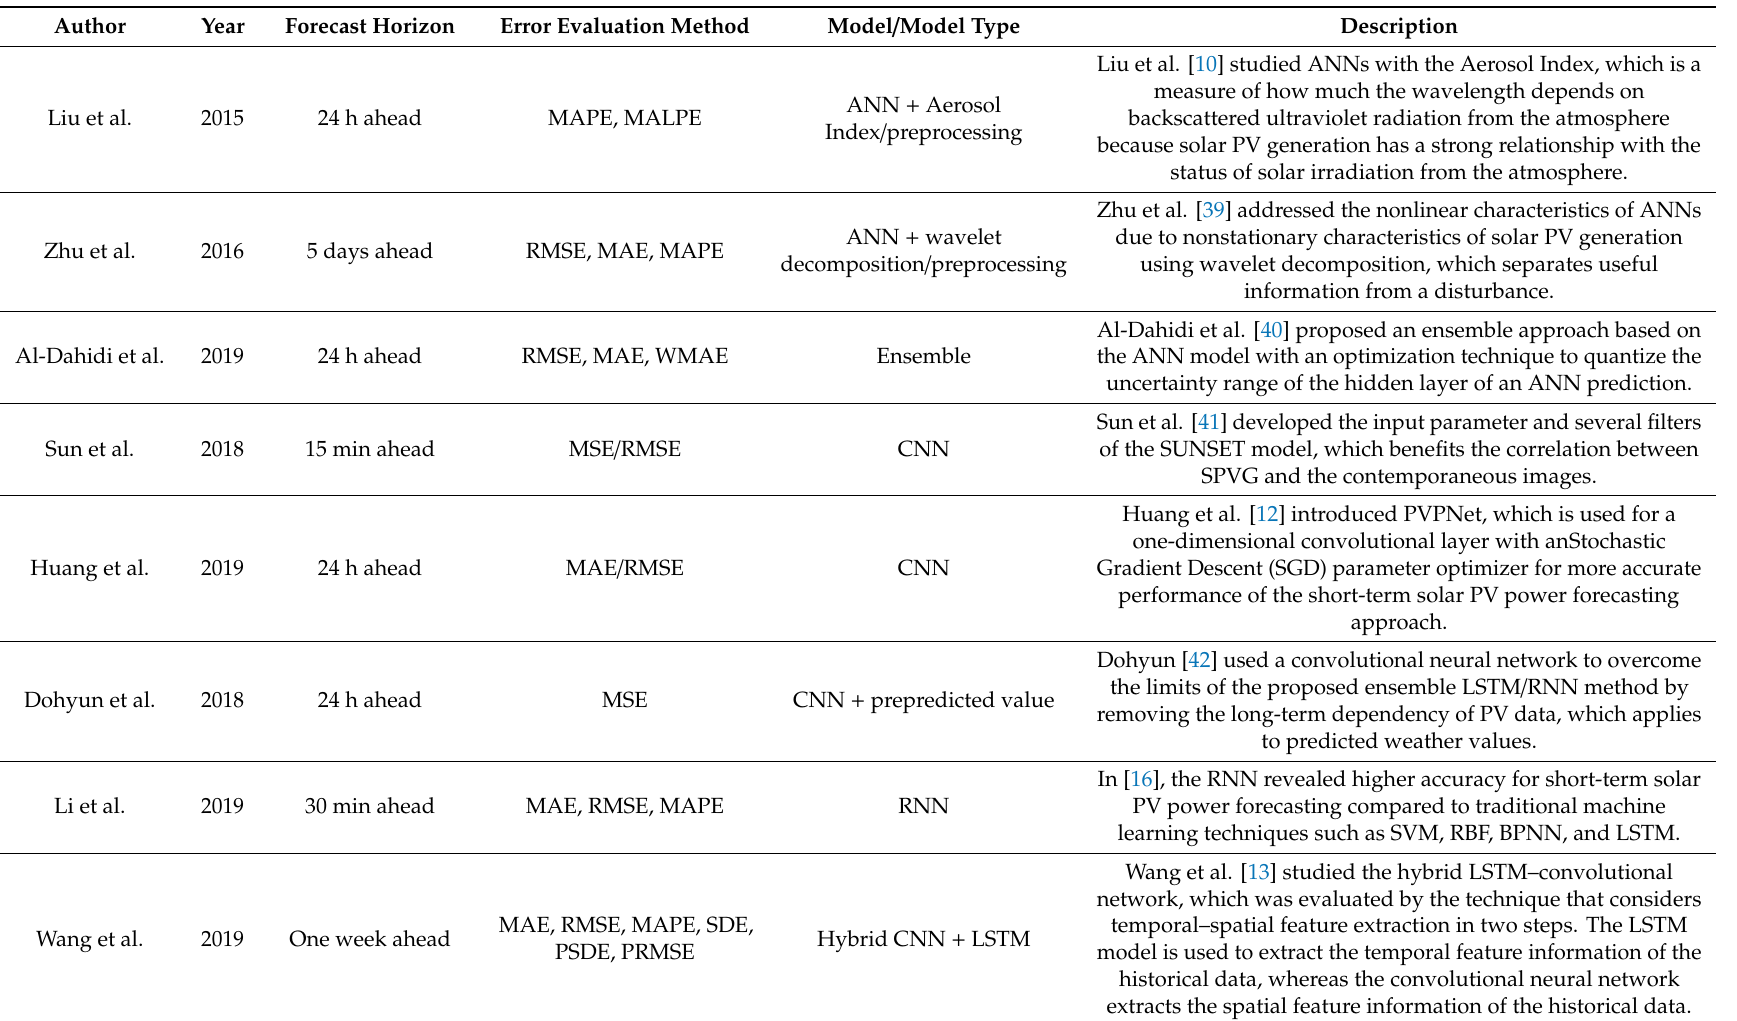
Table 1. Comparison of recent work for deep neural networks applied in solar photovoltaic power